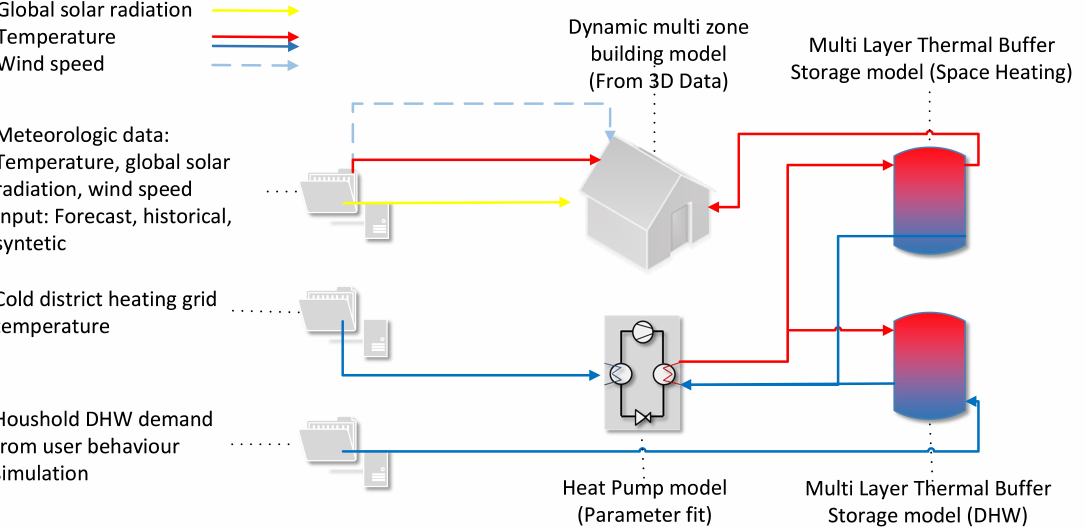
Figure 1. Integrated white-box model (INSEL) combining the dynamic building model with the energy conversion